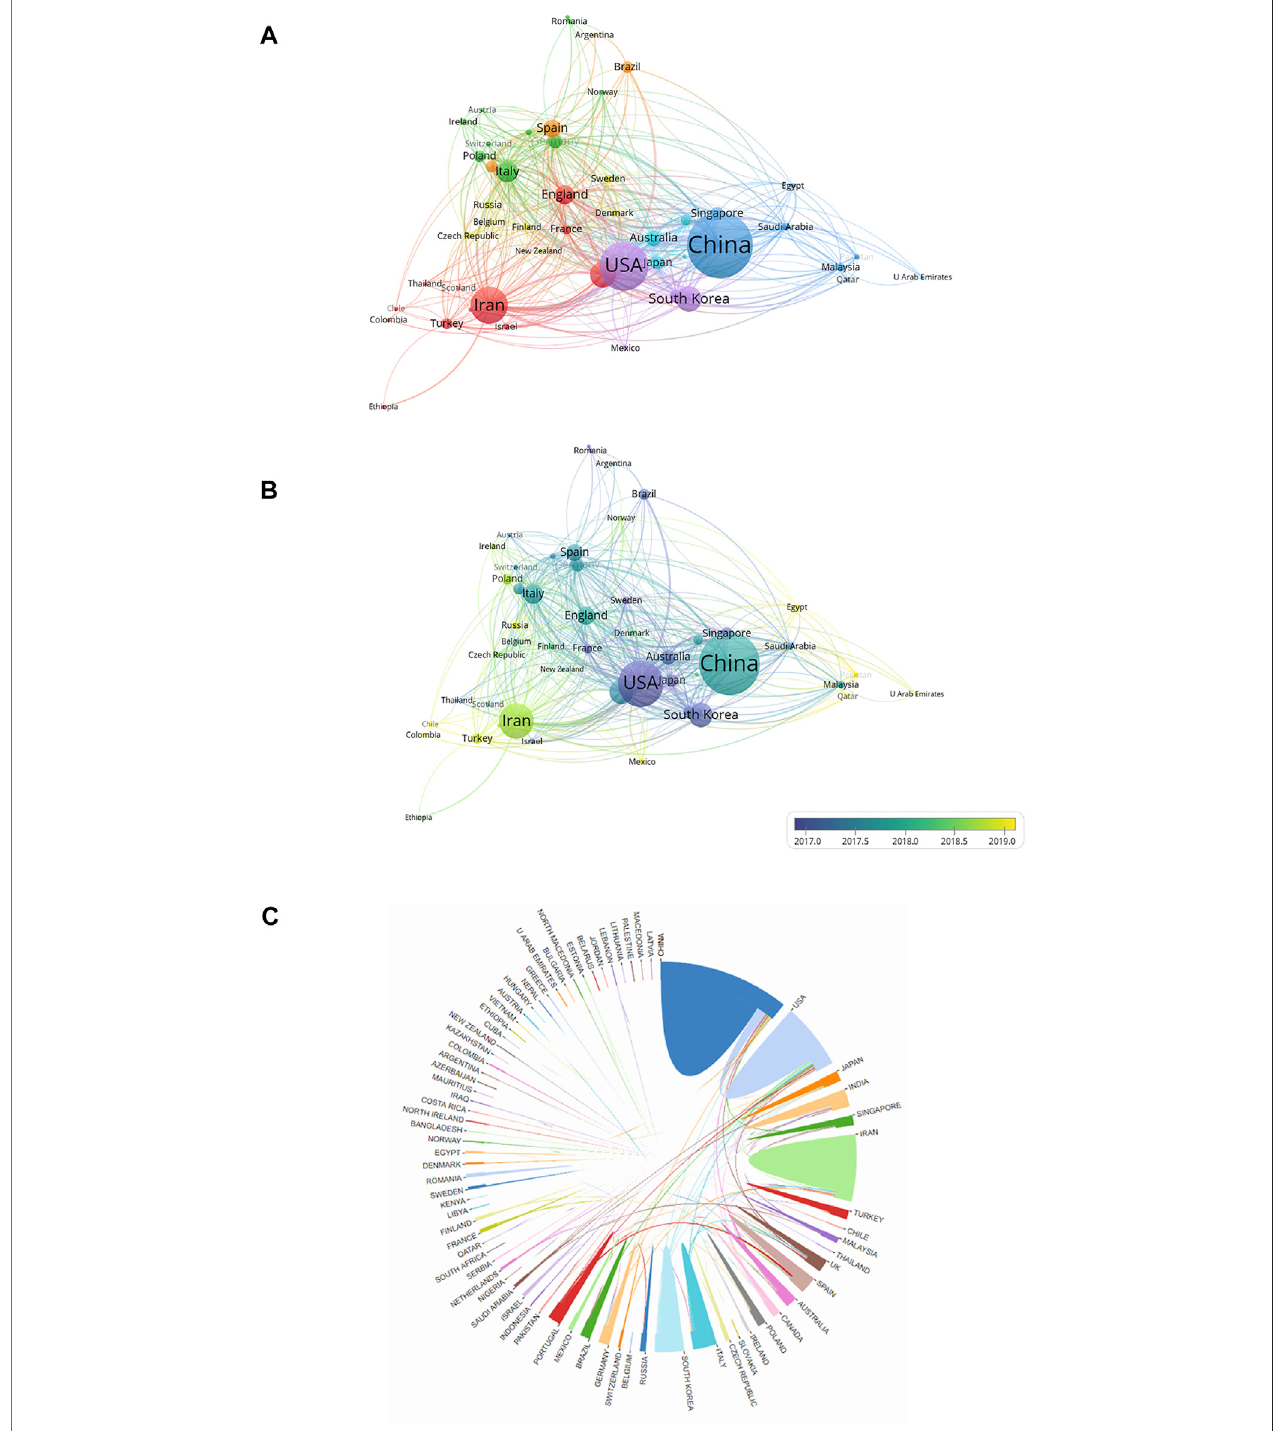
FIGURE 5 | Cooperation network of countries/regions with regard to research on electroactive biomaterials used in TE. (A) The network of cooperative relations between countries/regions was established with VOSviewer; (B) Concentrated years of publications for different countries; (C) The cooperative relations between countries/regions were